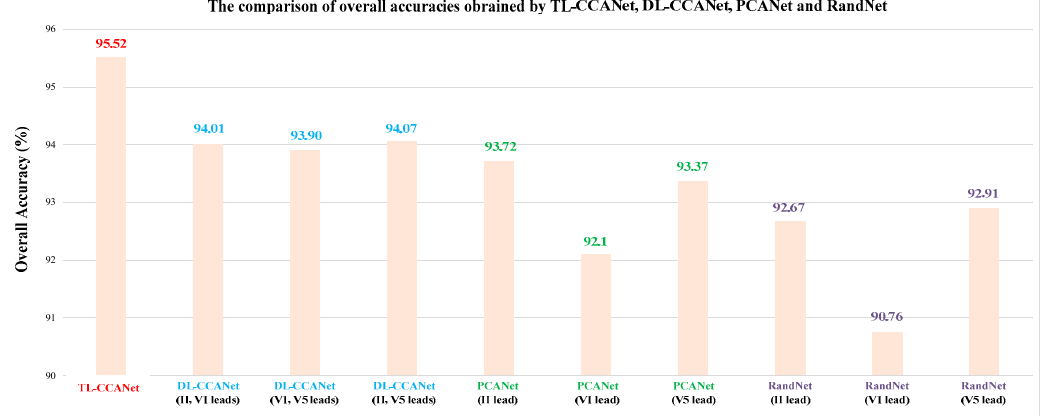
Figure 6. The comparison of the ECG classification performances of each fold ( a ) TL-CCANet, DL-CCANet, PCANet, and RandNet on INCART database. ( b ) TL-CCANet, PCANet(II) and RandNet(II); ( c ) TL-CCANet, PCANet(V1) and RandNet(V1); ( d ) TL-CCANet, PCANet(V5) and RandNet(V5).